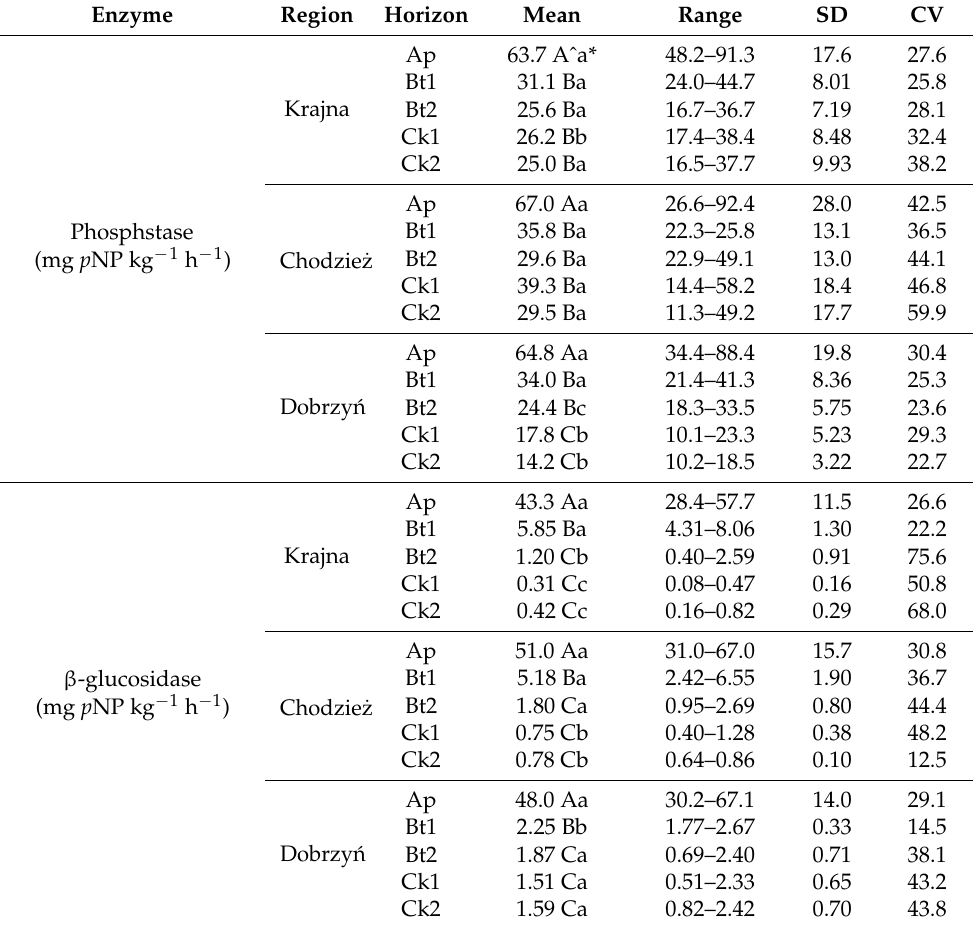
Table 4. Basic statistics of studied soil C- and P-related hydrolases.